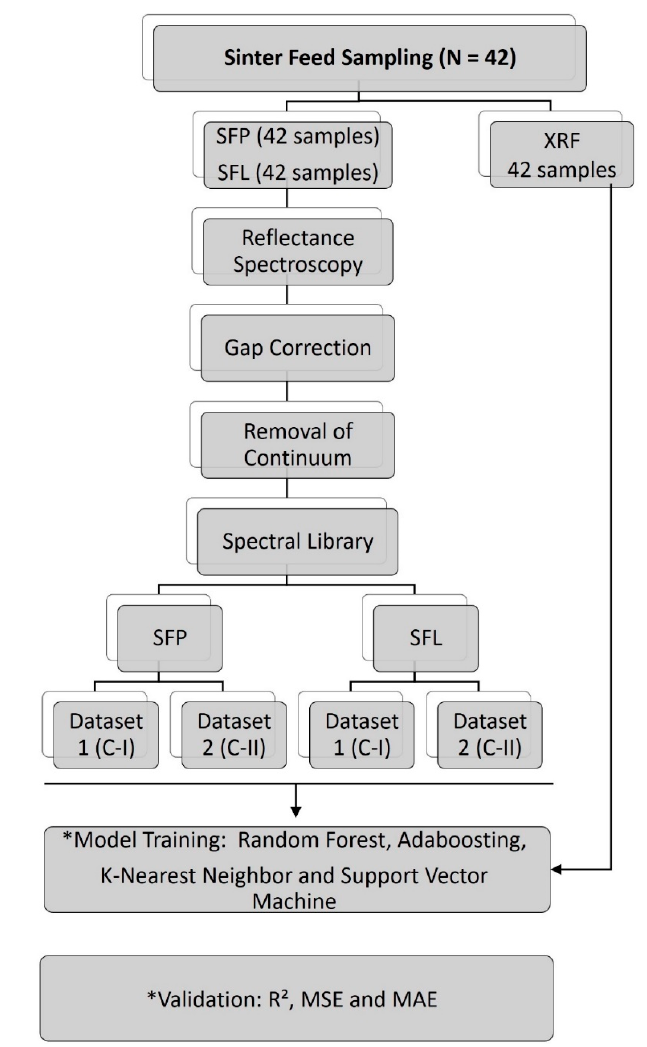
Figure 2. Flowchart showing the methodology used: * SFP—Sinter Feed Product; SFL—Sinter Feed Prepared in Laboratory; XRF-X-ray Fluorescence; R 2 —coefficient of determination; MSE—mean square error; MAE—mean absolute